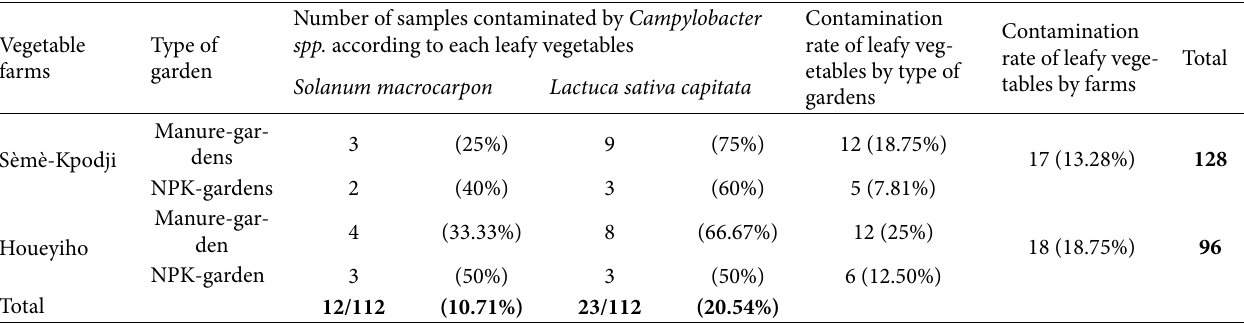
Table 4: Contamination rate of two leafy vegetable species